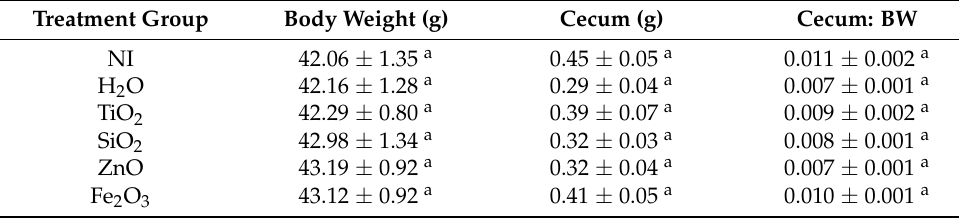
Table 3. Body weight, cecum weight, and cecum:body weight ratio in all groups 1 .